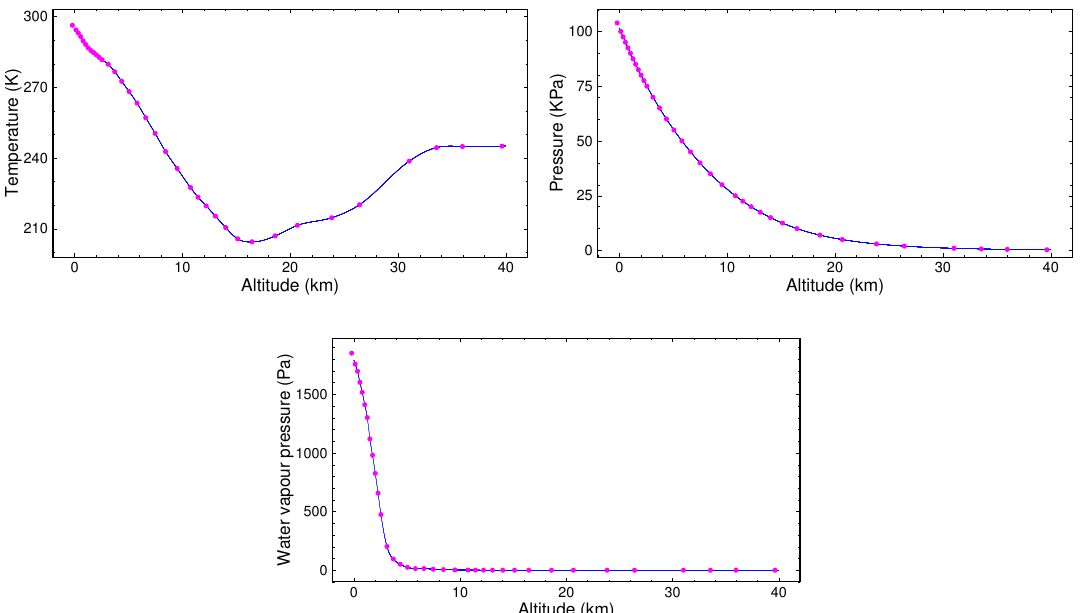
Figure 5. Spline interpolation for temperature, pressure, and water vapor pressure along the vertical